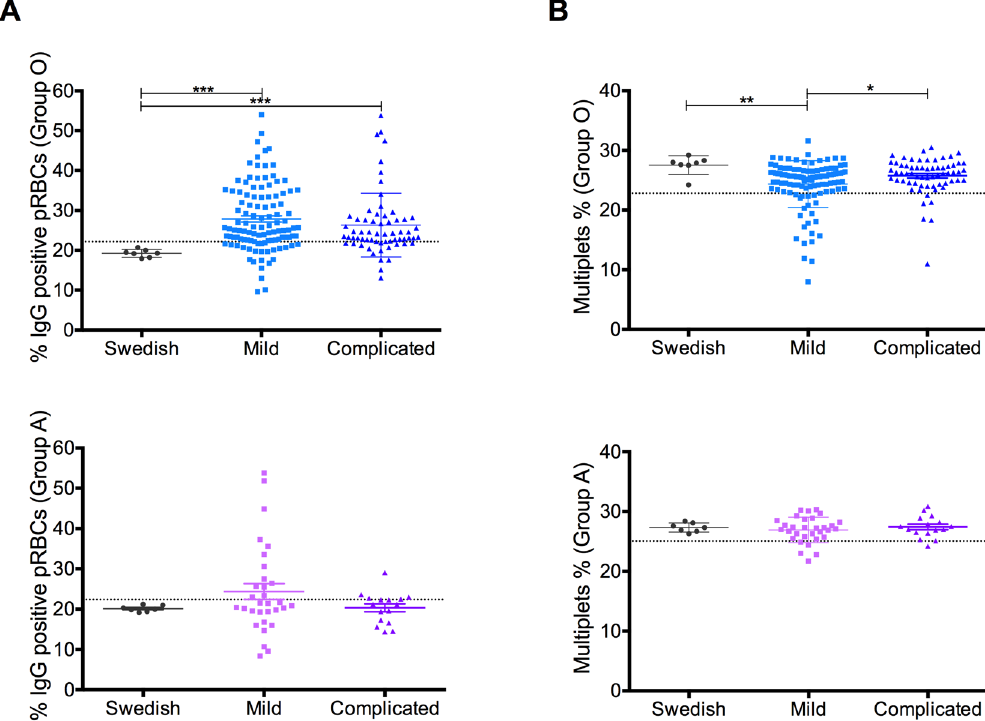
Figure 2. Surface reactivity and rosette disruption capacity. ( A ) Percentage of IgG positive pRBCs (measure of the surface reactivity) and ( B) Percentage of multiplets (measure of the rosetting rate) in the presence of pediatric sera, both in group O (top panels) and group A RBCs (low panels) stratified by malaria clinical presentation (mild and complicated) and compared with Swedish adults controls. Scatter dot plots show the means and SD. Differences between the groups were determined using a Kruskal-Wallis test. The dotted lines on each graph represent the threshold above/below which samples were considered as positive